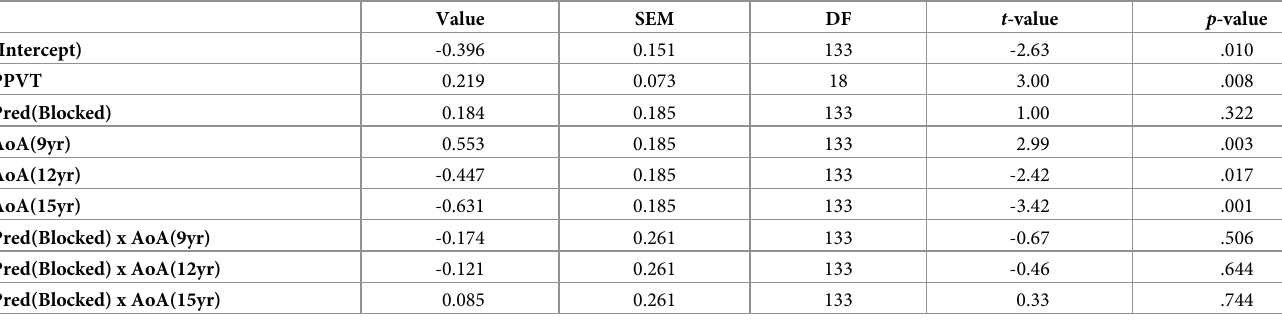
Table 2. Linear mixed model for results of Experiment